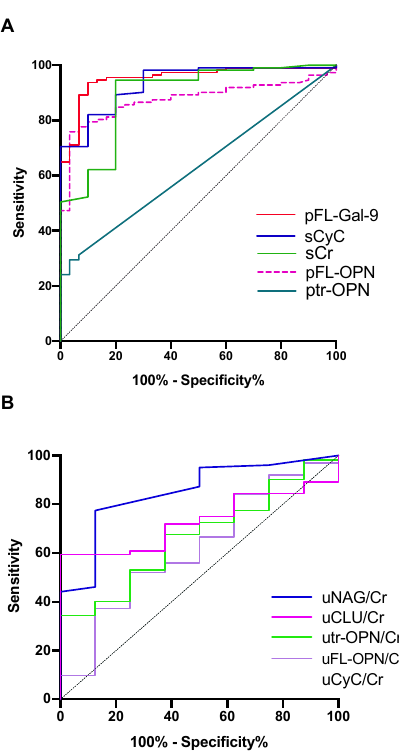
Figure 2. Receiver operating characteristic (ROC) curve analysis to discriminate leptospirosis patients from healthy controls. ( A ) Markers measured in plasma or serum; ( B ) markers measured in urine samples. Higher area under the ROC curve (AUC) values indicate a better ability to diagnose leptospirosis patients. FL-Gal-9, full-length galectin-9; CyC, cystatin C; Cr, creatinine; FL-OPN, full-length osteopontin; tr-OPN, thrombin-cleaved osteopontin; NAG, N -acetyl-β- D -glucosidase; CLU, clusterin; p, plasma; u, urine.